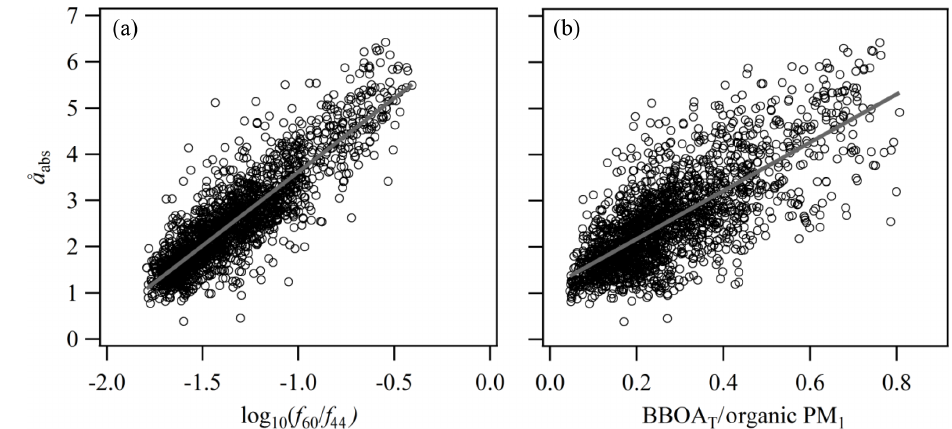
Figure 13. Relationships between the absorption Ångström exponent and indicators of biomass burning. Scatter plots of å abs against (a) log 10 (f 60 /f 44 ) of the AMS analysis ( R = 0 . 87), and (b) the ratio of the BBOA T loading to the organic PM 1 mass concen- tration ( R = 0 . 75). BBOA T loading is the sum of the MO-BBOA and LO-BBOA factor loadings. The å abs value corresponds to 370 to 430nm. In panel (a) , the slope and intercept are 3 . 2 ± 0 . 1 and 6 . 8 ± 0 . 1, respectively. In panel (b) , they are 5 . 2 ± 0 . 1 and 1 . 1 ± 0 . 1.